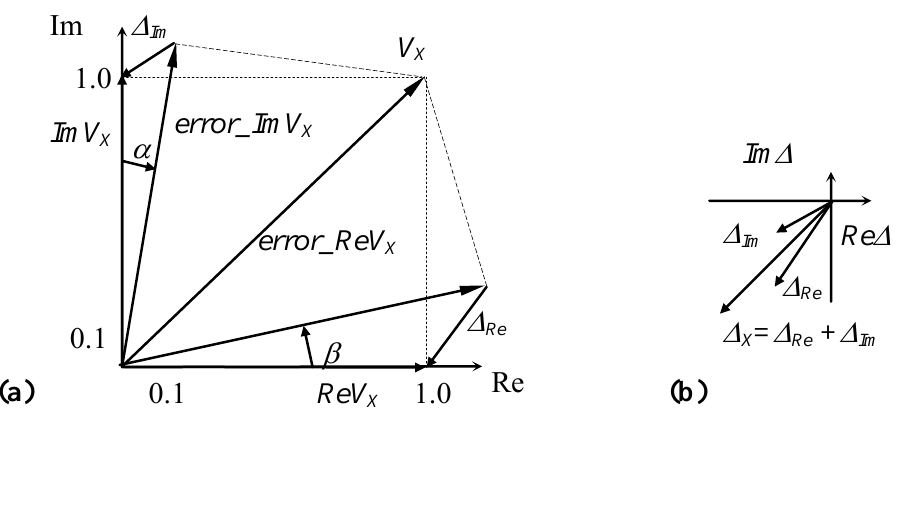
X . (b) Error vector